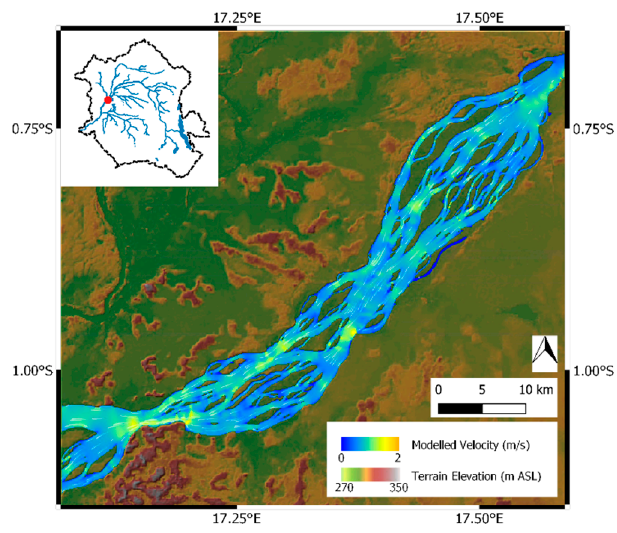
Figure 22. Water surface output plot of flow velocity downstream of the Ubangi confluence, from the Hec-Ras 2D channel model, described by Carr et al. (under review) [119].